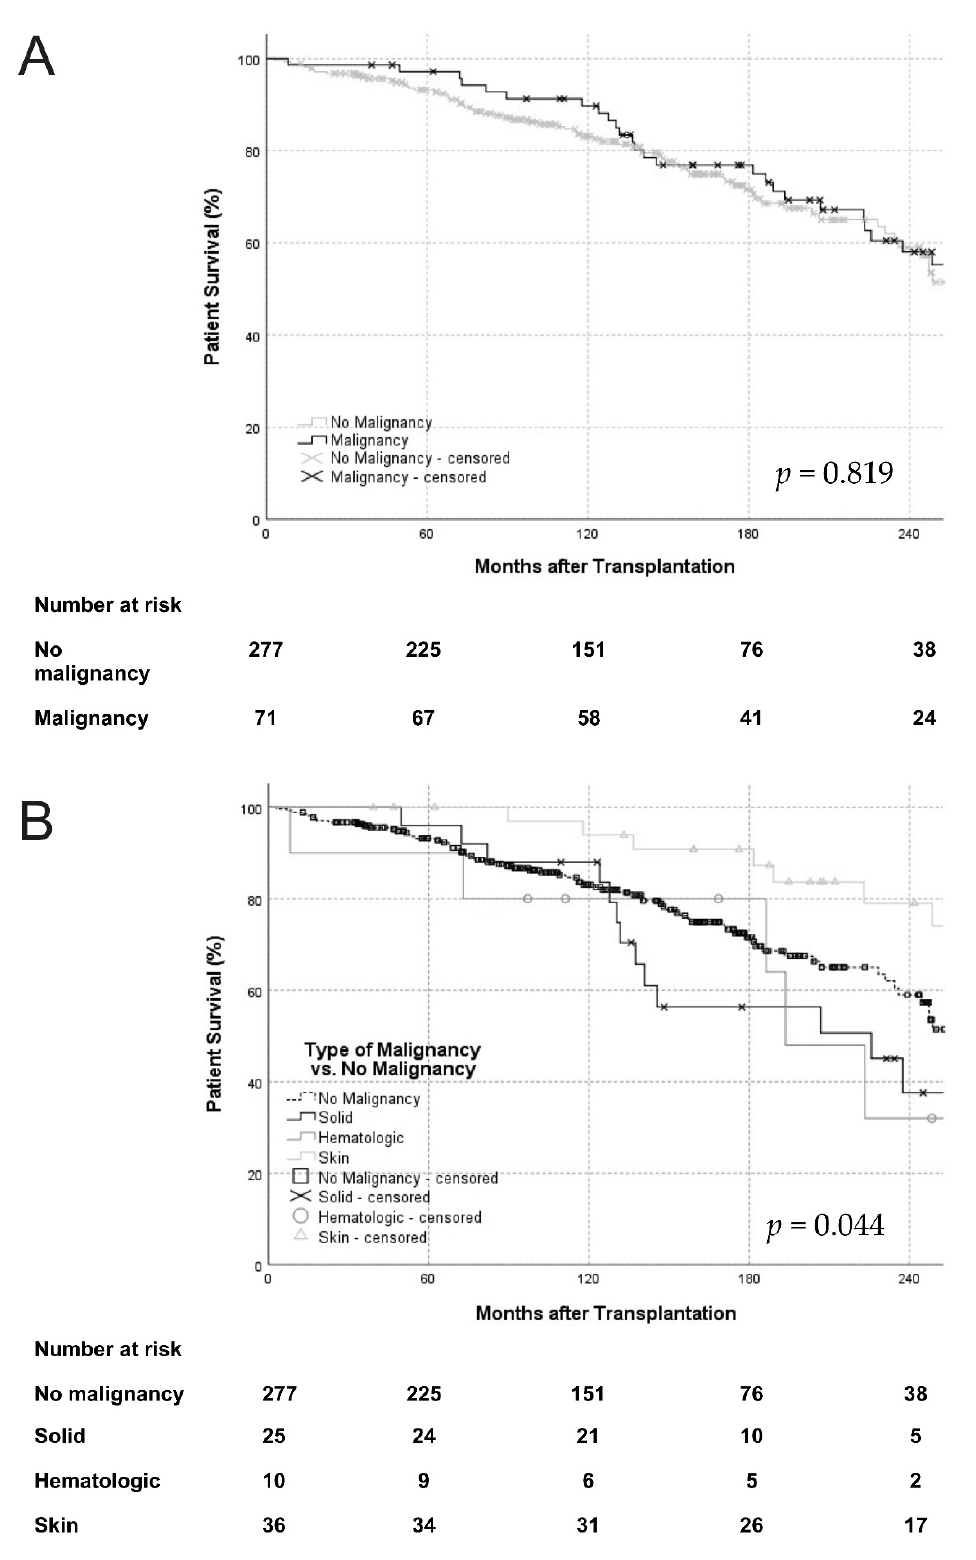
Figure 2. Overall patient survival ( A ) and patient survival based on the type of PTM ( B ). Overall patient survival was similar between patients with and without PTM (log-rank p = 0.819) but significantly different when stratified according to the type of PTM (log-rank p = 0.044). PTMs, post-transplant malignancies . All-cause pancreas and kidney graft survival were comparable between groups.